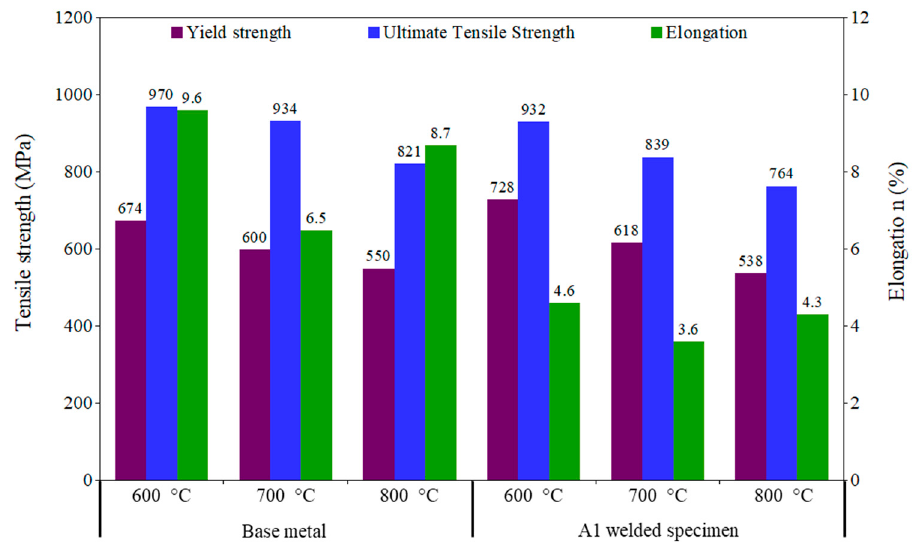
Figure 13. Tensile strength of BM and the HAZ of A1 welded samples at different temperatures. (cid:48) Main factors such as size, volume fraction and distribution of γ precipitates influence the mechanical properties of precipitation-hardened nickel-based superalloy [45,46]. As mentioned in (cid:48) Figure 8, welding increased the size of γ precipitates for a similar volume fraction, which extended the inter-precipitate distance and diminished the stress needed to a displacement of dislocations to bow around precipitates